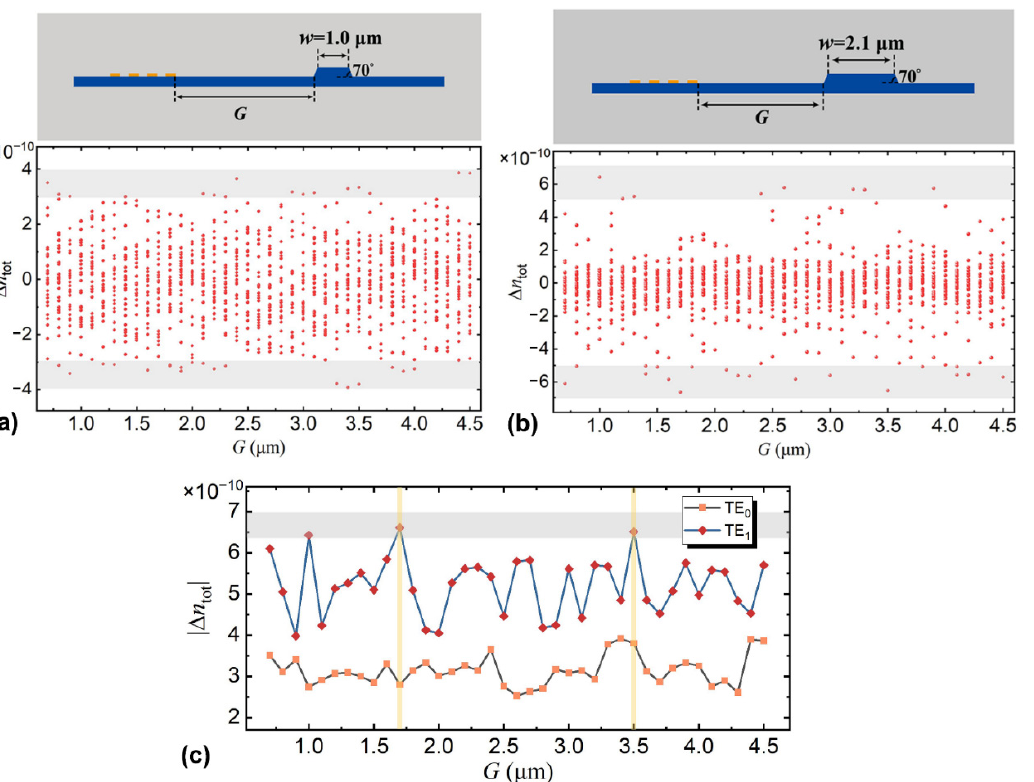
Figure 3. Refractive index change of the optical waveguide ∆ n tot as a function of the gap width G between the optical waveguide and IDT working at the ( a ) fundamental TE 0 mode and ( b ) higher- order TE 1 mode. ( c ) The maximum refractive index change of the optical waveguide | ∆ n tot | versus the same gap width G for both the TE 0 and TE 1 mode. The results are calculated for a single phonon.